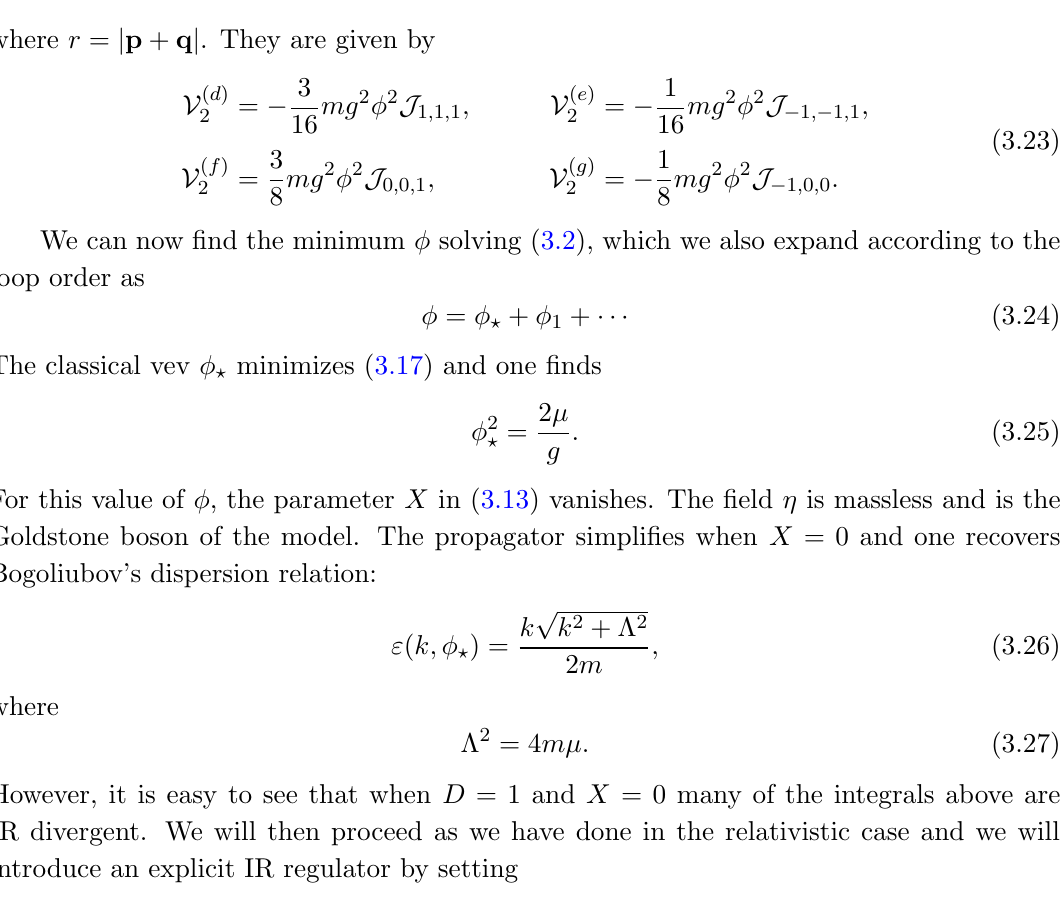
Figure 11 . Two-loop diagrams for the Lieb-Liniger